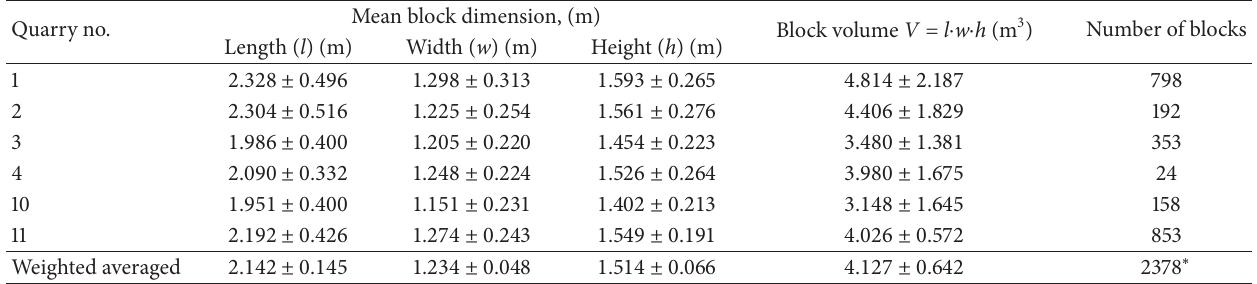
Table 4: Mean length, height, width, and volume of the limestone blocks produced at limestone quarries in the Karaburun limestone quarries. Quarry no.